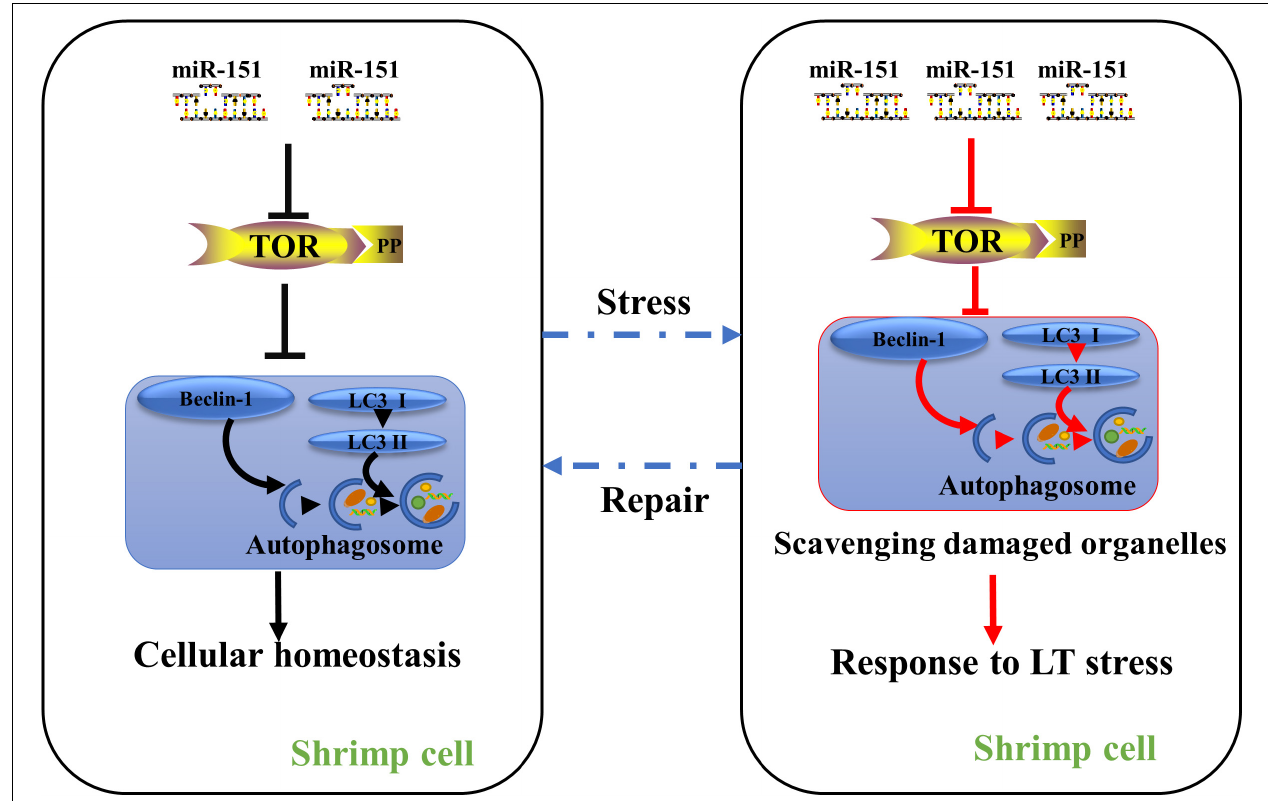
FIGURE 9 | A proposed model for the role of miR-151 in low-temperature tolerance. Under normal physiological conditions, miR-151 mediates the expression of PvTOR to maintain intracellular homeostasis. When the shrimp were exposed to low-temperature stress, inhibiting miR-151 reduces the accumulation of TOR and p-tor, thereby regulating the expression of autophagy-related proteins, resulting in increasing the accumulation of autophagosomes. The accumulated autophagosomes contribute to degrading these organelles such as damaged mitochondria. To alleviate hepatopancreas injury induced by acute low temperature in shrimp. Red lines indicate increased pathways, whereas blank lines indicate maintain intracellular homeostasis